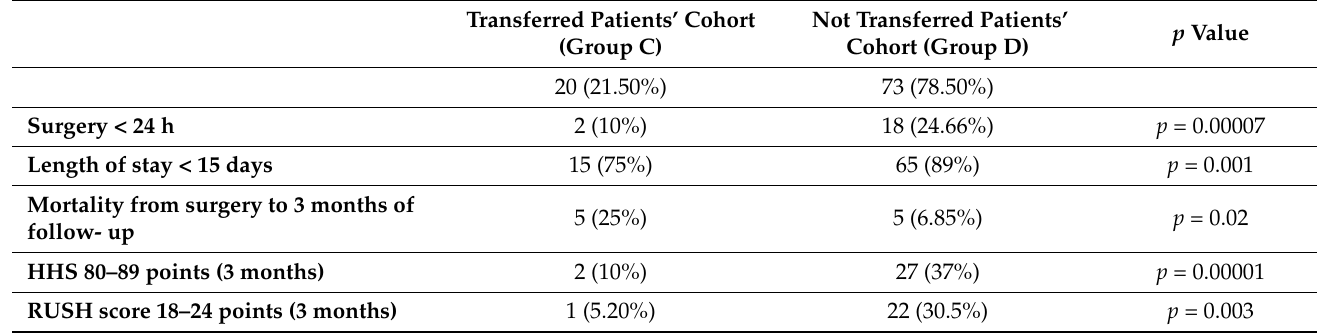
Table 3. Main results obtained comparing transferred patients’ cohort with the not transferred